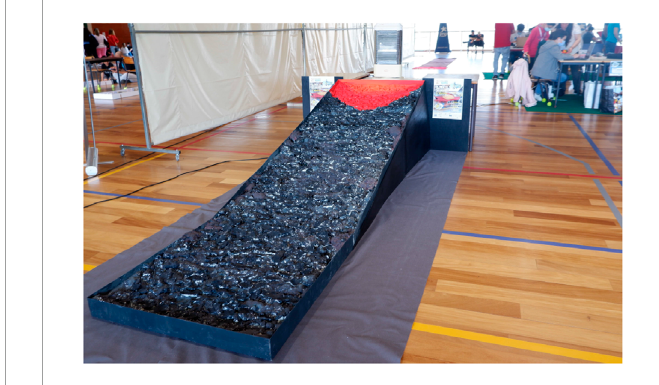
FIGURE 4 Challenge ramp in the Azoresbot 2022.